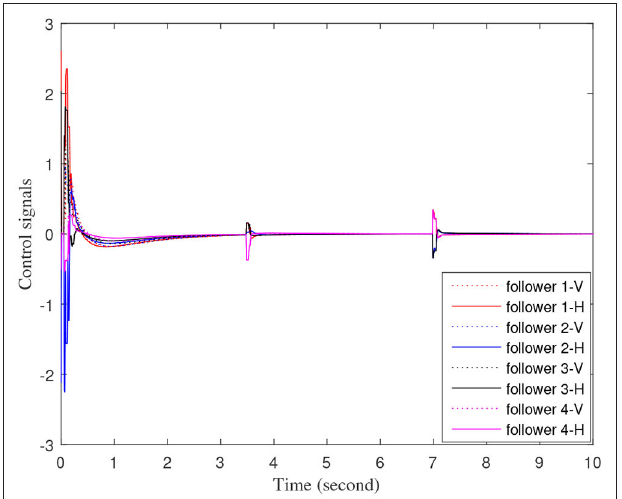
FIGURE 7 | The position information of the vehicle when the formation is stable.